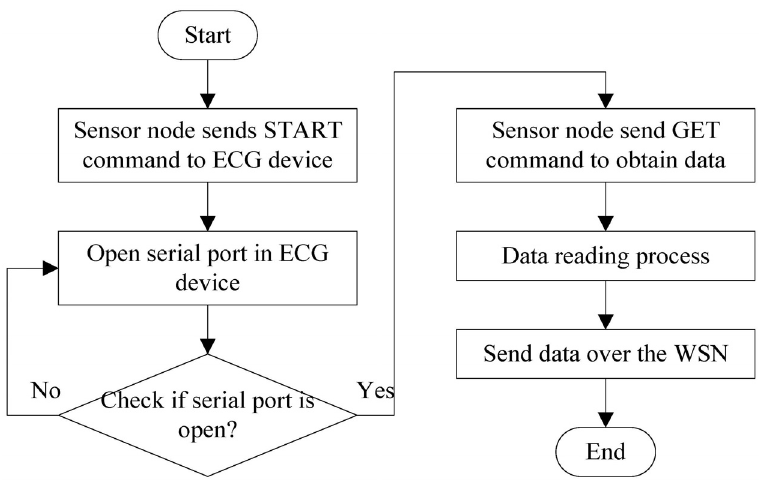
Figure 7. Communication between the sensor node and the ECG